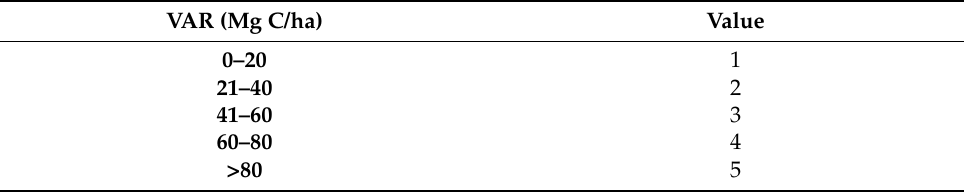
Table A2. Vegetation and soil carbon stock assigned values for the Value at Risk rating.